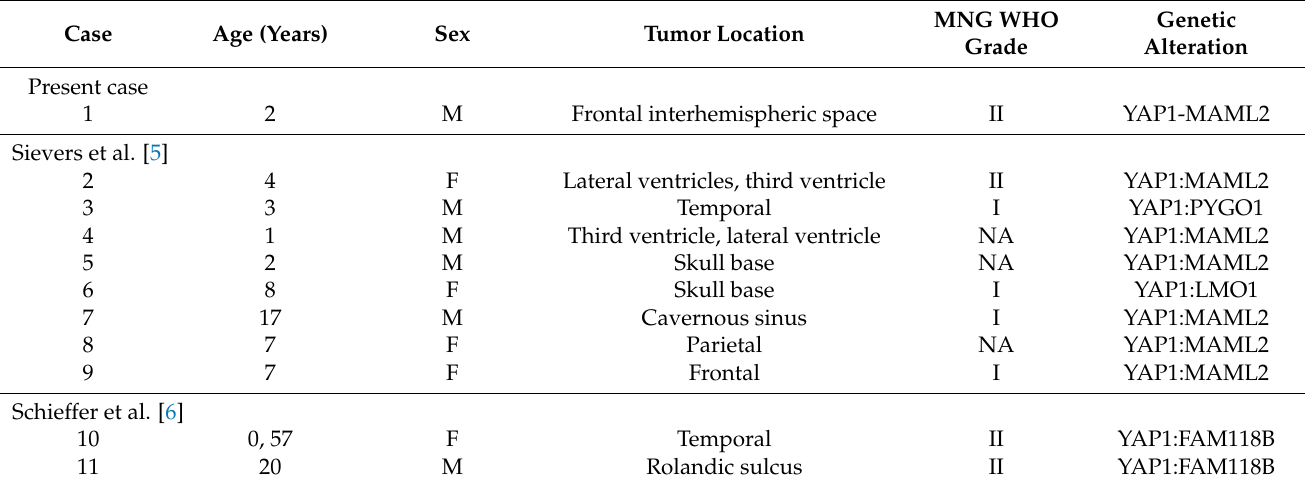
Table 1. Clinico-pathological features of reported pediatric patients with YAP1-fusion-positive